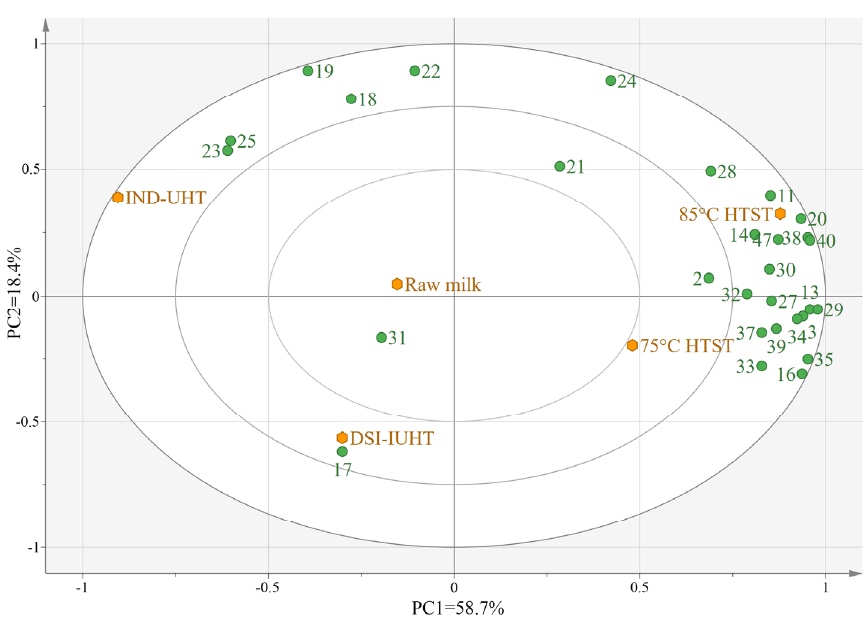
Figure 6. PCA of the five milk samples subjected to SAFE. The orange plots represent the five milk samples. (The numbers correspond to VCs is shown in Table 3.)